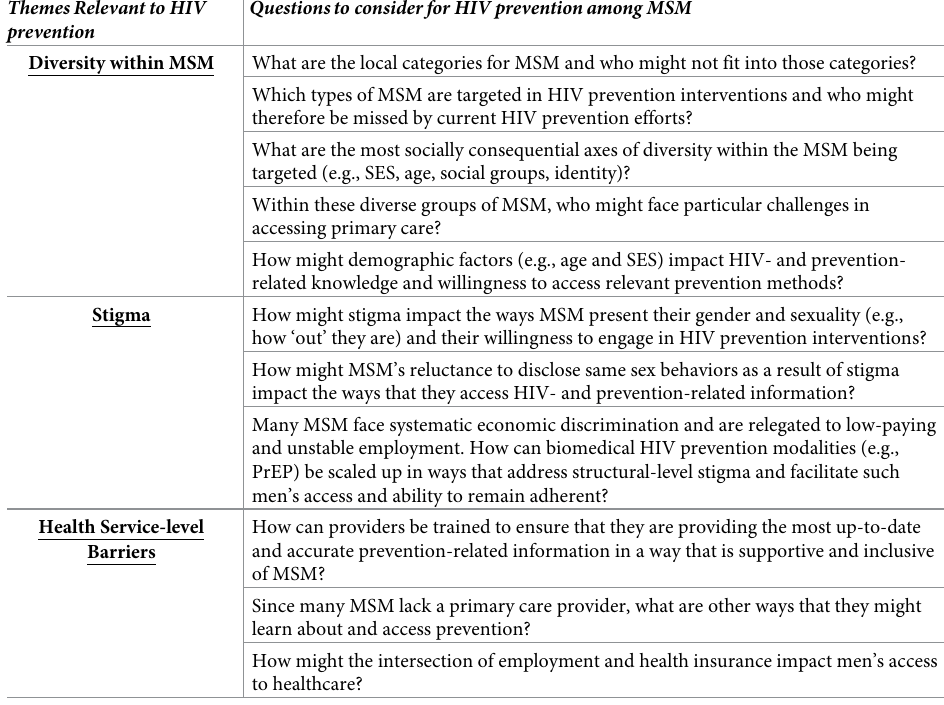
Table 2. Questions to consider when scaling-up HIV prevention for